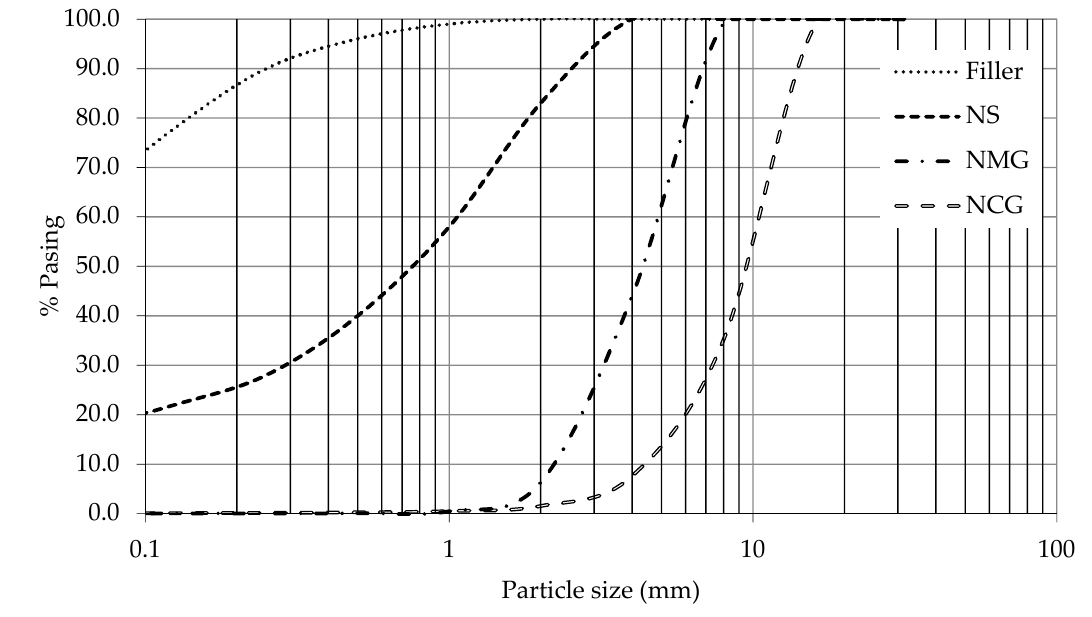
Figure 1. Particle size distribution curve. Table 2. Physical and chemical properties of natural aggregates and